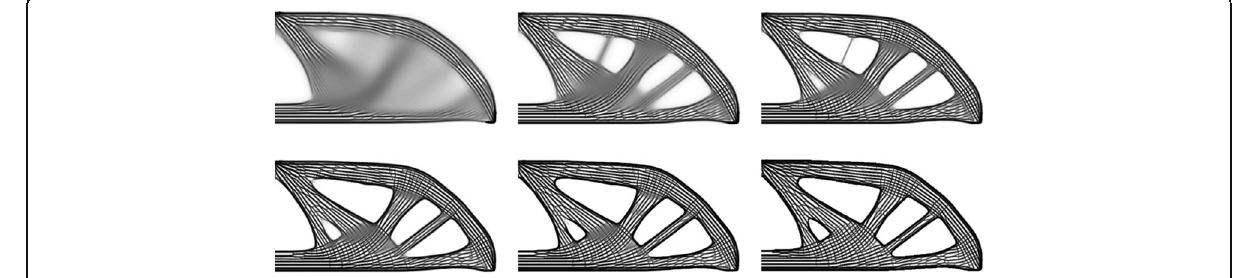
Fig. 8 The iteration process of topology optimization